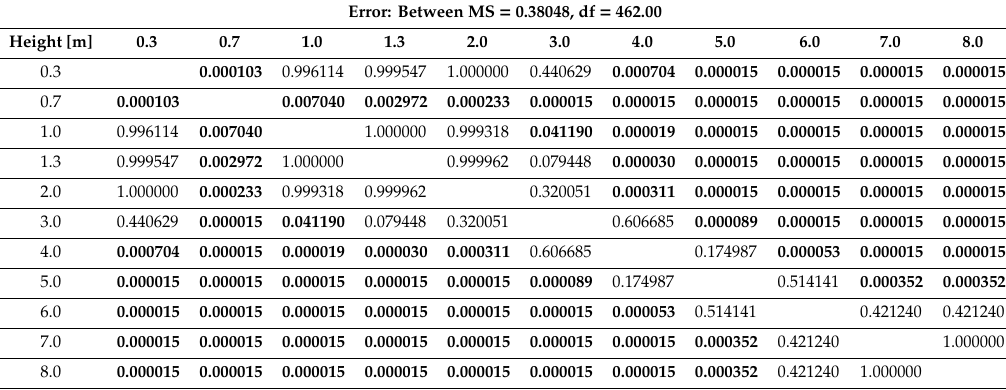
Table A3. Results of one-way ANOVA post hoc Tukey HSD test for HMLS data. Error: Between MS = 0.38048, df = 462.00